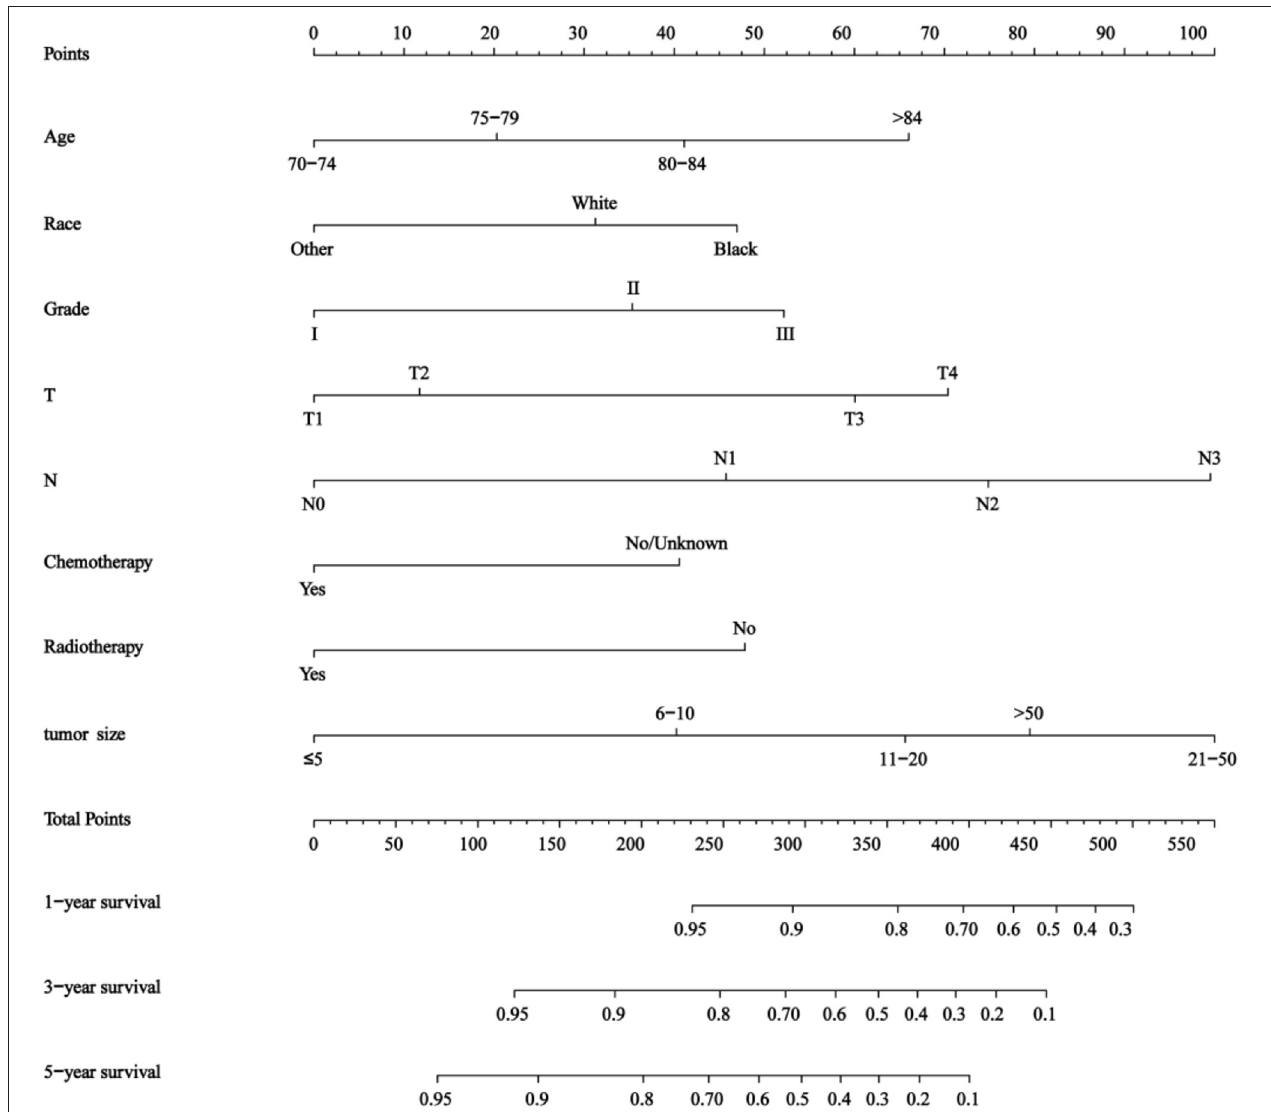
FIGURE 2 | Nomogram for predicting 1-, 3-, and 5- year overall survival (OS) in elderly patients with triple-negative breast cancer (TNBC).